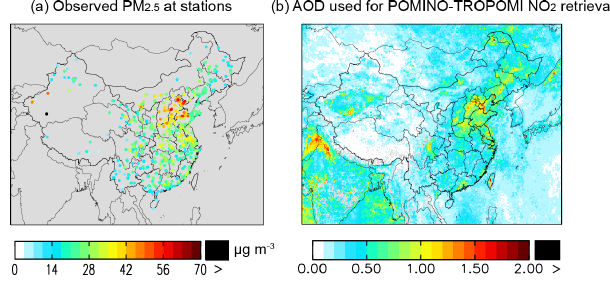
Figure 2. (a) Observed near-surface PM 2 . 5 mass concentrations av- eraged over July 2018. Results are sampled at the times of valid TROPOMI data. (b) AOD data on a 0 . 05 ◦ × 0 . 05 ◦ grid used for the retrieval of POMINO-TROPOMI NO 2 VCDs in July